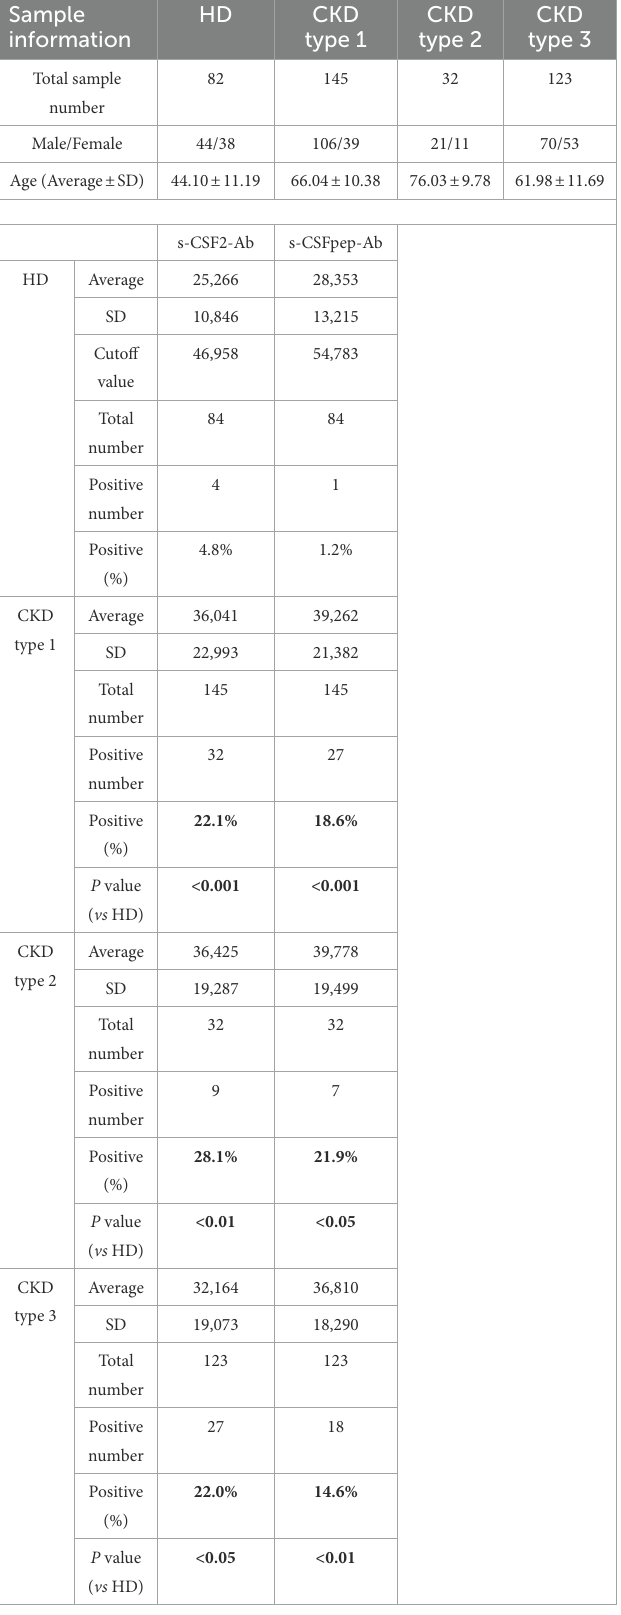
TABLE 3 The s-CSF2-Ab and s-CSF2pep levels associated with CKD. TABLE 4 Association between s-CSF2-Ab levels and the data from